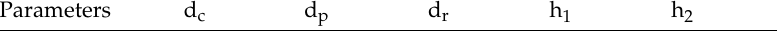
Figure 9. ( a ) A simulation model of the truncated EBG structure with a 2 × 2 array and ( b ) comparison of PPN suppressions of the UC-DDM and the full-wave simulation. Table 1. Dimensions of the PP-EBG UC for verification of the UC-DDM.